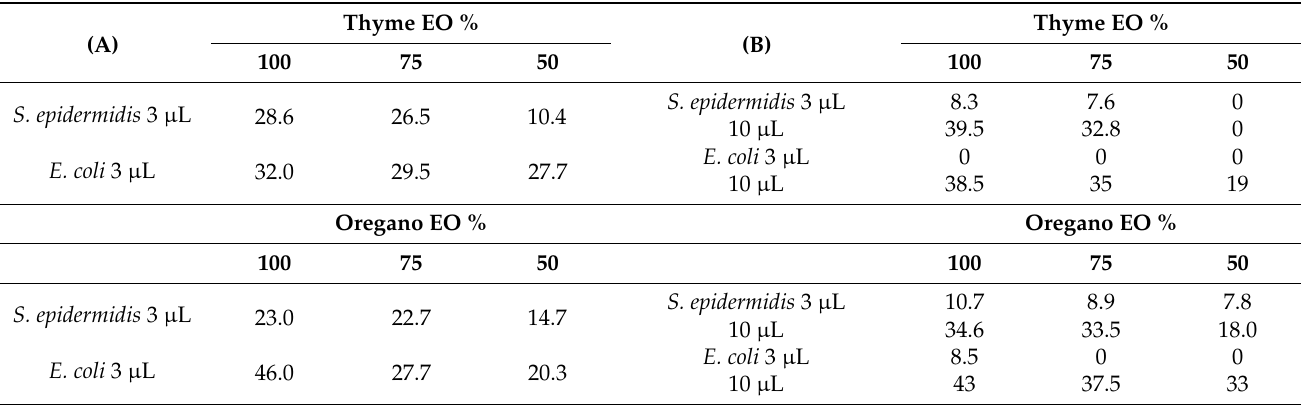
Table 1. Comparison of the inhibition zones (mm) measured after 48 h of incubation at 37 °C in the presence of thyme or oregano EOs against S. epidermidis and E. coli . ( A ) Agar disk diffusion; ( B ) disk volatilization.